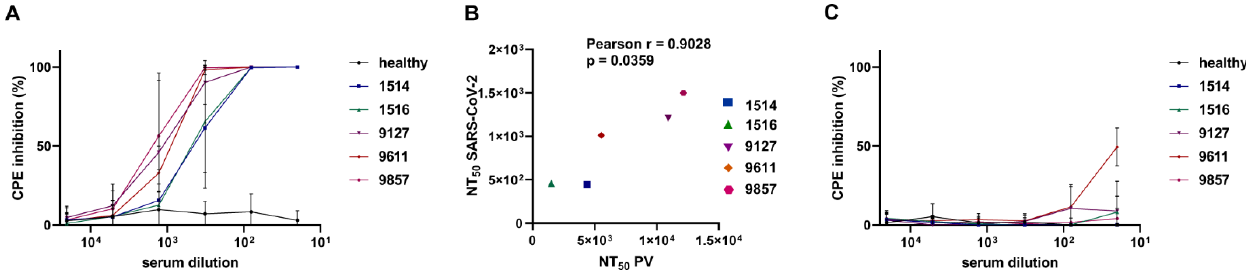
Figure 4. Neutralization activity of convalescent sera against replication-competent SARS-CoV-2. ( A ) Serum activity against the purified SARS-CoV-2 virions. Serial fourfold dilutions of serum samples from convalescent donors were incubated with SARS-CoV-2 and added to the Vero E6 cells. Cell survival was determined 5 days later by MTT test and expressed as a percentage of cytopathic effect (CPE) inhibition measured relative to untreated control, which was set at 100%. ( B ) Correlation between NT 50 serum-neutralizing titers measured with the ∆ F ∆ C19-PVs and the live SARS-CoV-2. ( C ) Serum-neutralizing activity against SARS-CoV-2 in cell coculture conditions. Serial fourfold dilutions of serum samples from convalescent donors were incubated with SARS-CoV-2 infected Vero E6 cells, which were then mixed with uninfected Vero E6 cells at a 1:2 ratio. The results were collected and presented as in ( A ). The average results from three independent experiments with standard deviations are shown in ( A , C